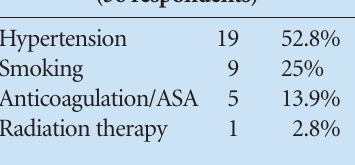
Table II. Risk factors for